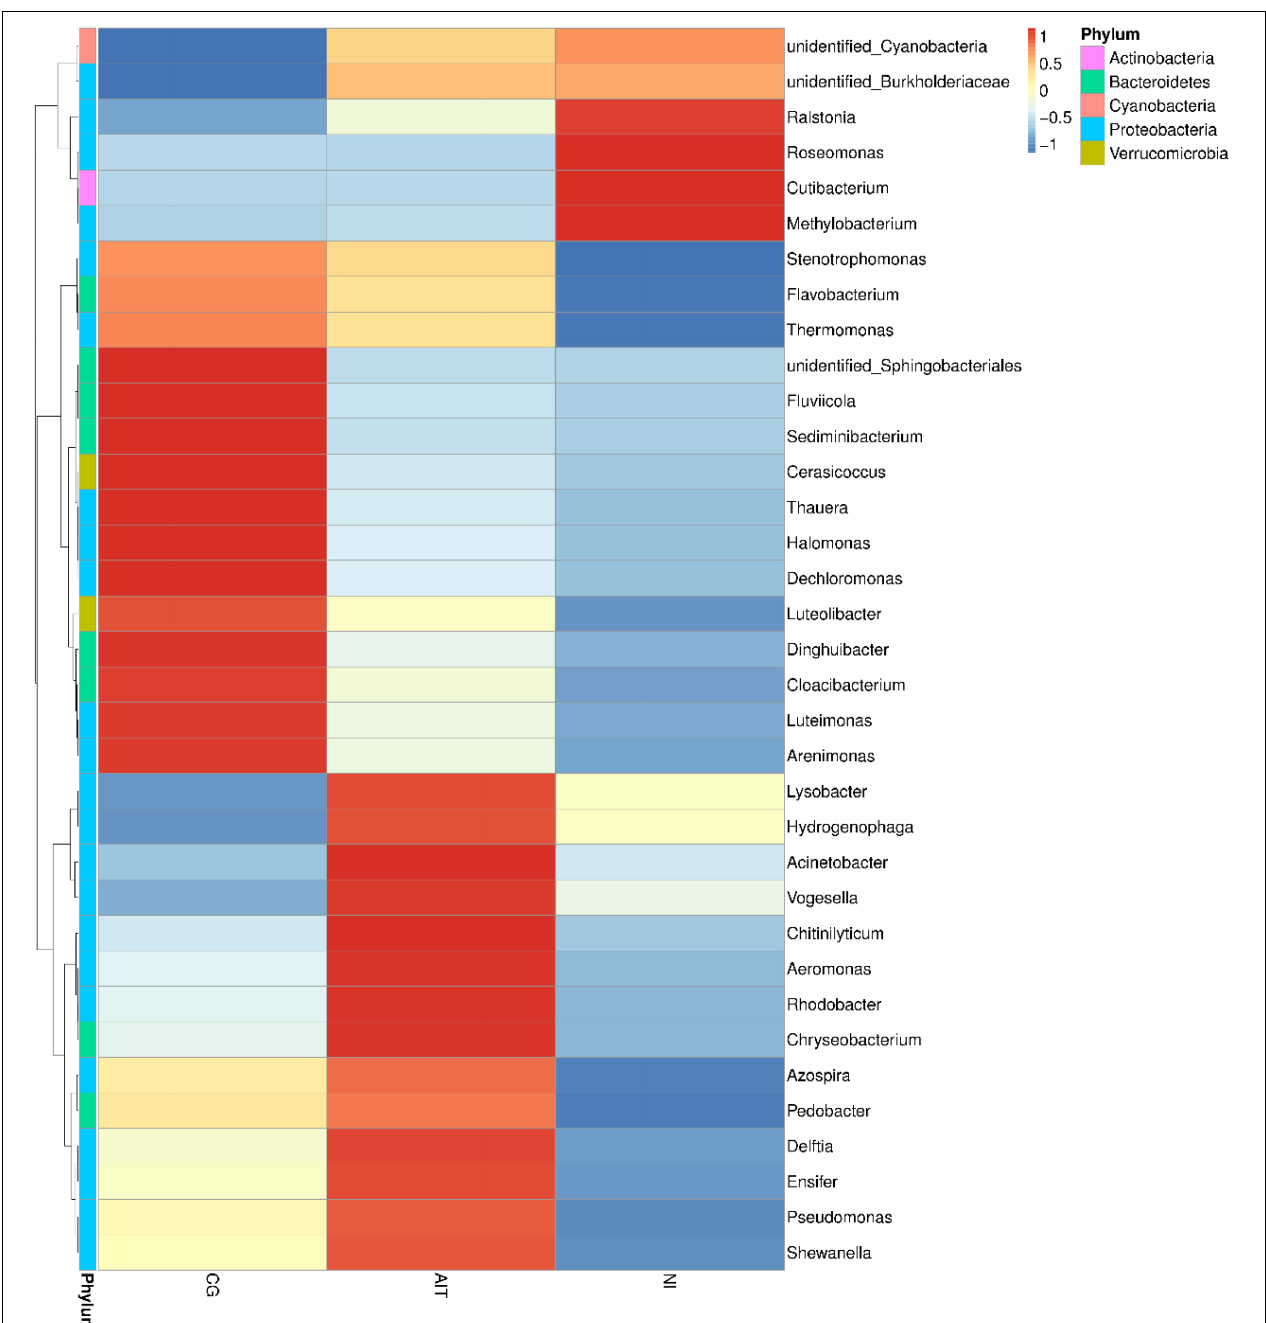
FIGURE 8 | Cluster analysis of different groups of microbial communities at the genus taxonomic level. CG, control group; AIT, artificial infection group, NI, natural erosion group.